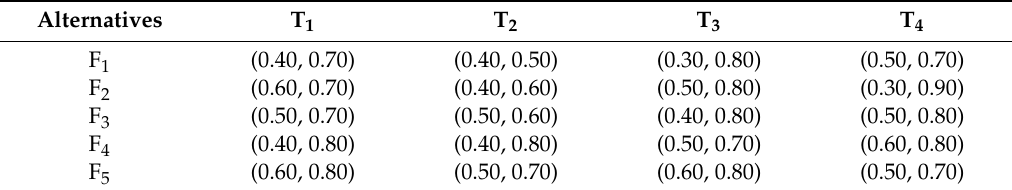
Table 1. Pythagorean fuzzy matrix by DM (decision maker) 1 .